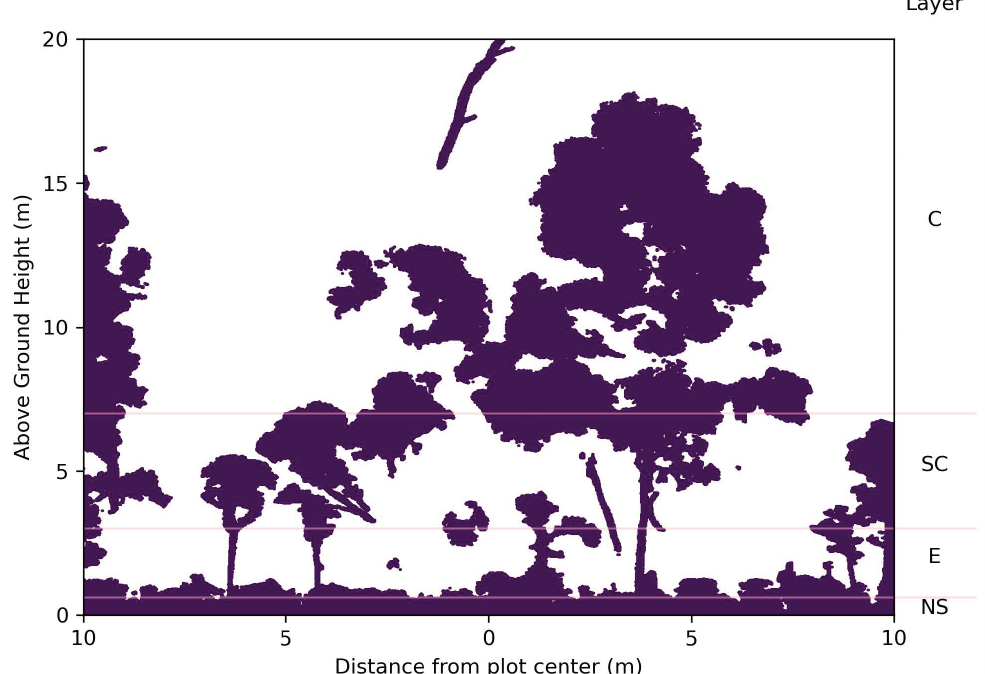
Figure 7. A hexbin plot of a 1m transect of the reference point cloud taken through the middle of the plot established as S2 (Clonbinane). The defined height of fuel strata are shown as pink